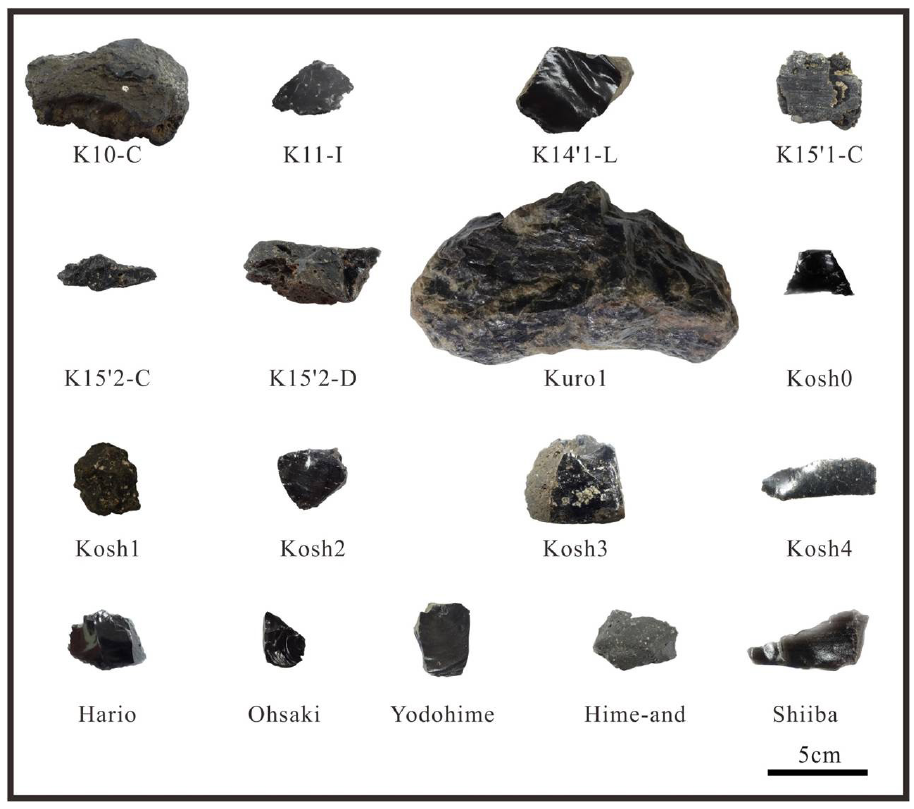
Figure 4. The Kyushu obsidians used in this study. The obsidian samples were collected from outcrops of seven localities: Koshidake (K10-C, K11-I, K14’1-L, K15’1-C, K15’2-C, K15’2-D, Kosh0, Kosh1, Kosh2, Kosh3, Kosh4), Kurogamiyama (Kuro 1), Hari- oshima (Hario), Ohsaki Peninsula (Ohsaki), Yodohime Higashihama (Yodohime), Himeshima (Hime-and), Shiibagawa